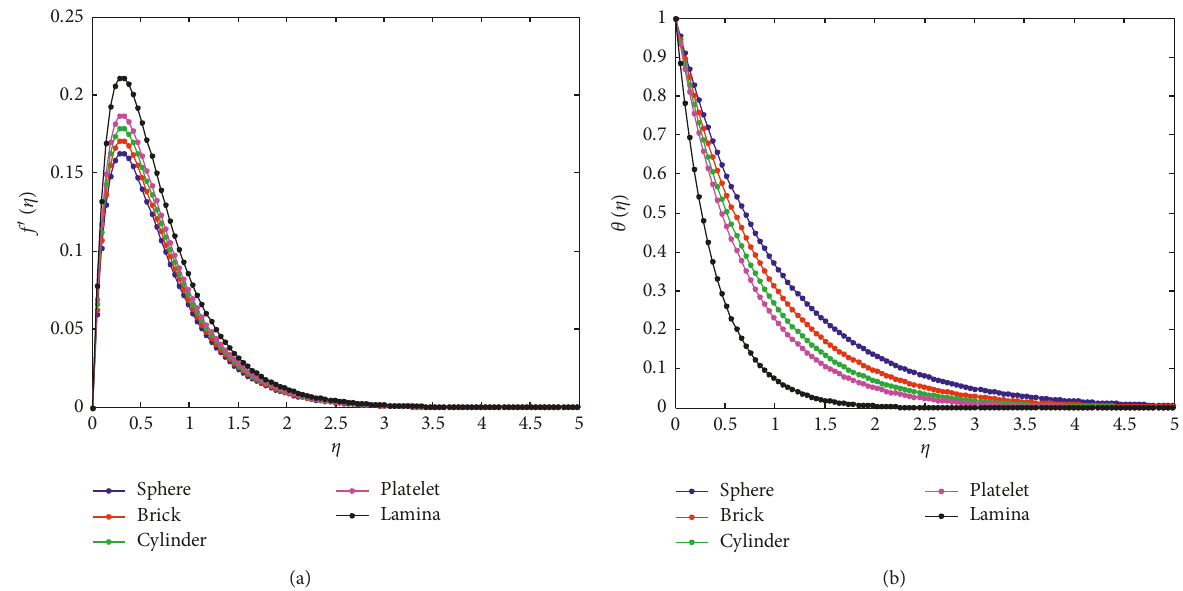
Figure 10: (a) Effect of nanoparticle shape on the velocity distribution of the nanofluid. (b) Effects of nanoparticle shape on the temperature distribution of the nanofluid.